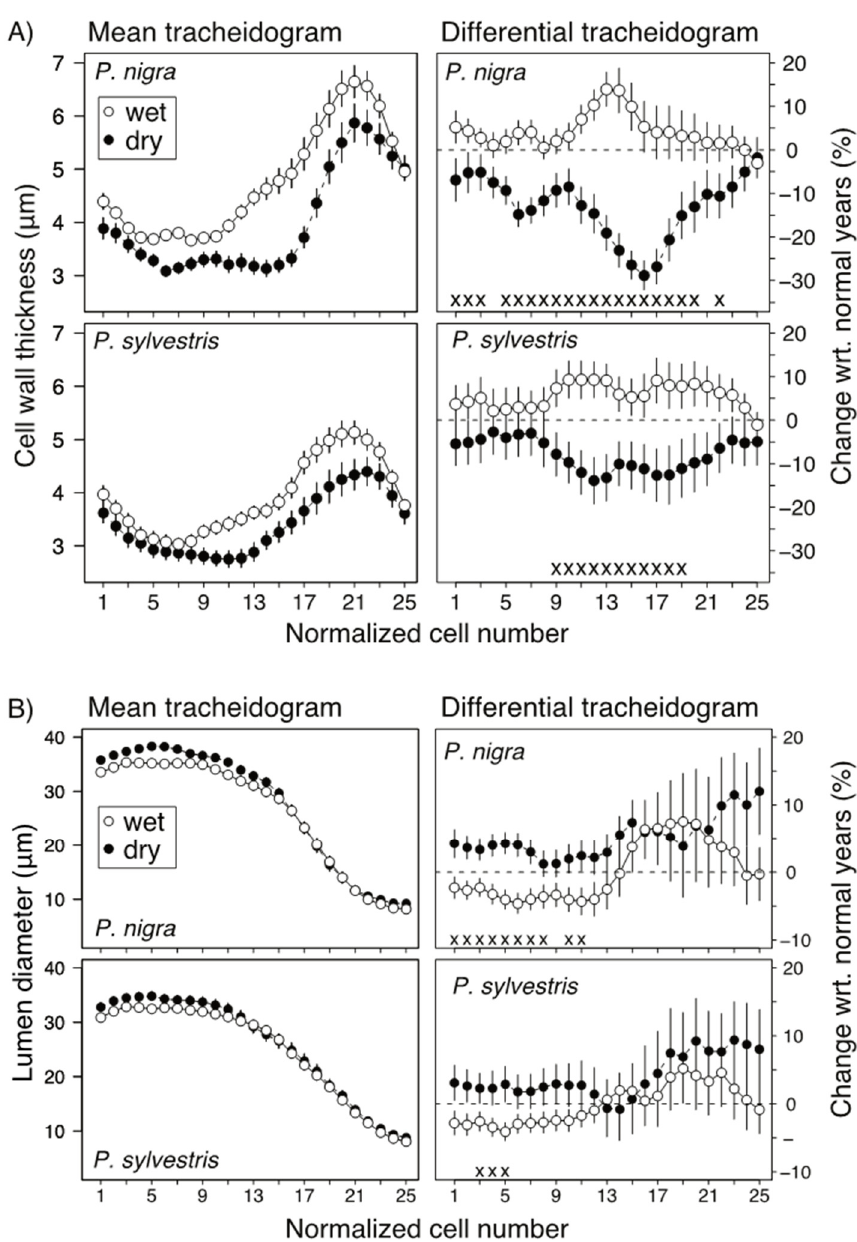
Figure 4. Mean tracheidogram (left panels) and differential tracheidogram (% change with respect to the species average years; right panels) for wet (white circles) and dry (black circles) years for cell-wall thickness ( A ) and lumen diameter ( B ) in P. nigra and P. sylvestris . Every ring has been normalized to 25 hypothetical cells (see text for details). Vertical bars represent standard error of the mean. Within each species, (x) symbols indicate significant differences ( p < 0.05) between dry and wet years.